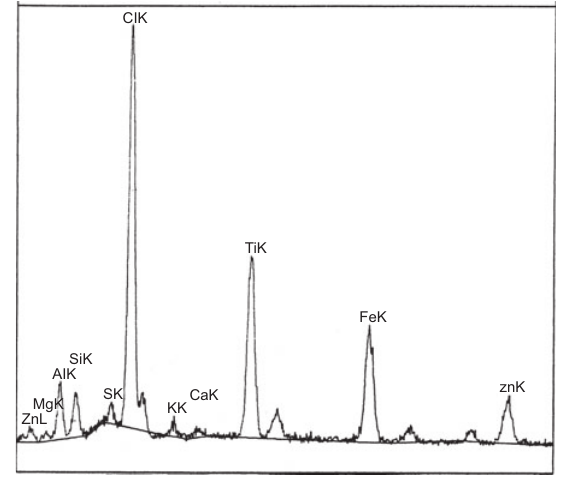
Figure 9 EDS spectra of unsealed sprayed ZAZA coatings after 2 years of experiment.